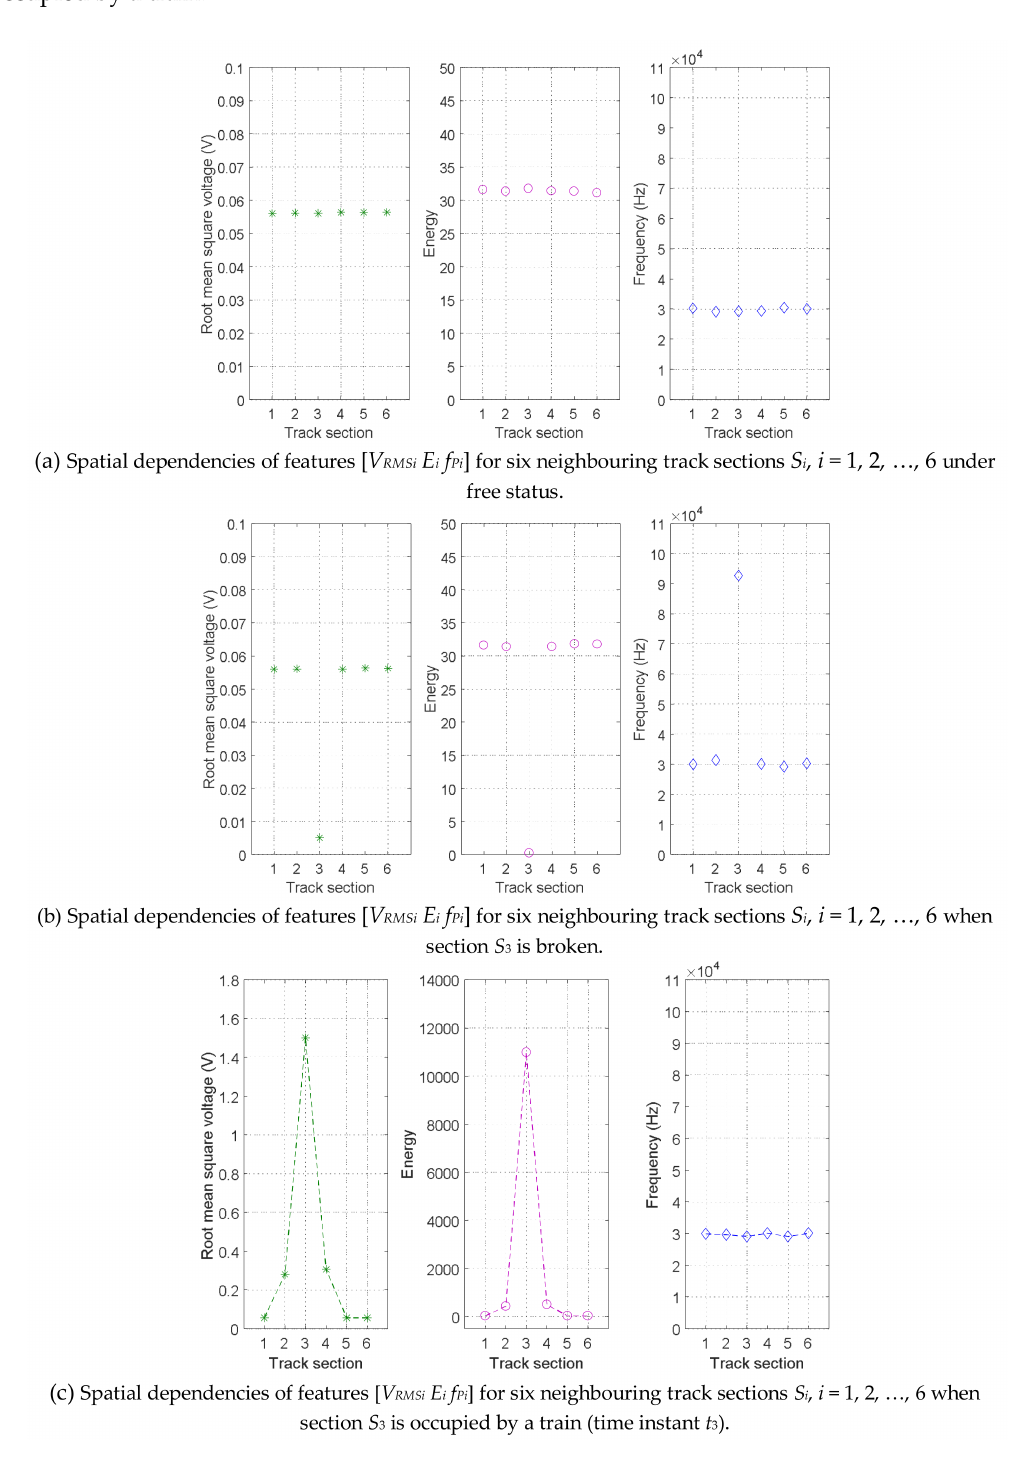
Figure 24. Spatial dependencies of features [ V RMSi E i f Pi ] for six neighbouring track sections S i , i = 1, 2, . . . , 6 in rail no. 1 under three different track